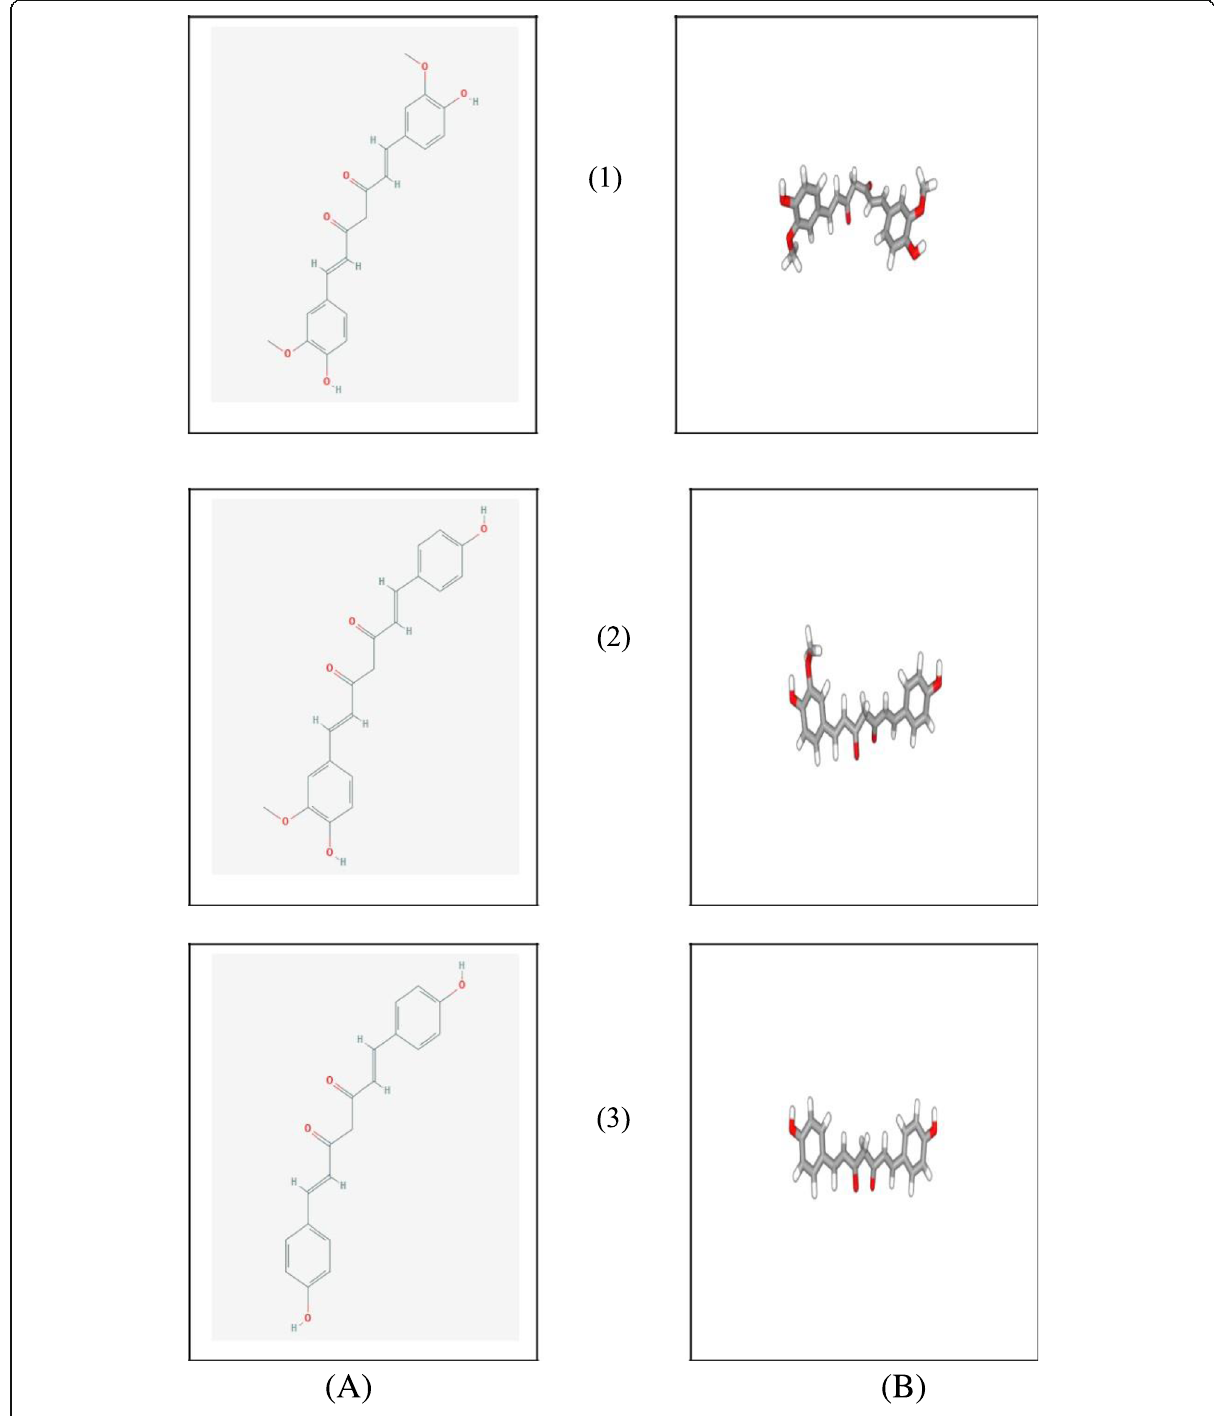
Fig. 3 Structures of (1) curcumin I (PubChem CID: 969516), (2) curcumin II (PubChem CID: 5469424), and (3) curcumin III (PubChem CID: 5315472); ( A ) 2D, ( B )